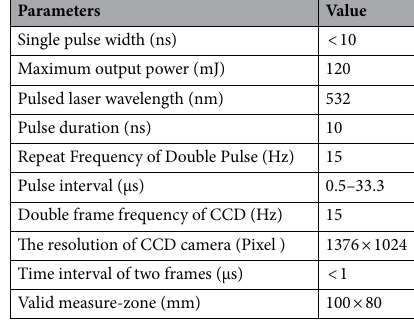
Table 3. Main parameters of PIV system.